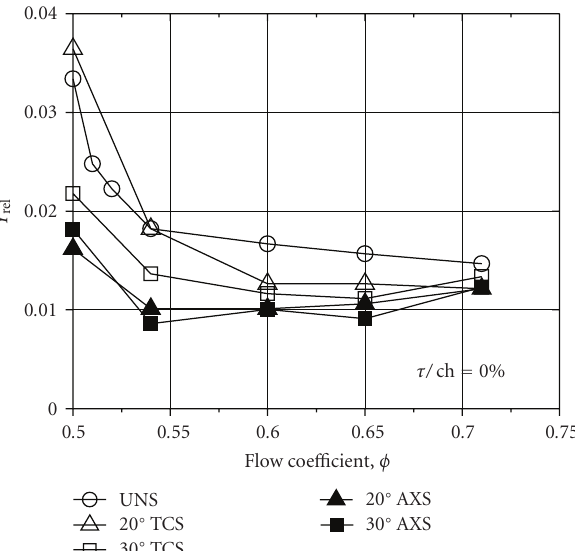
Figure 8: Stagnation pressure loss coe ffi cient across rotor versus φ